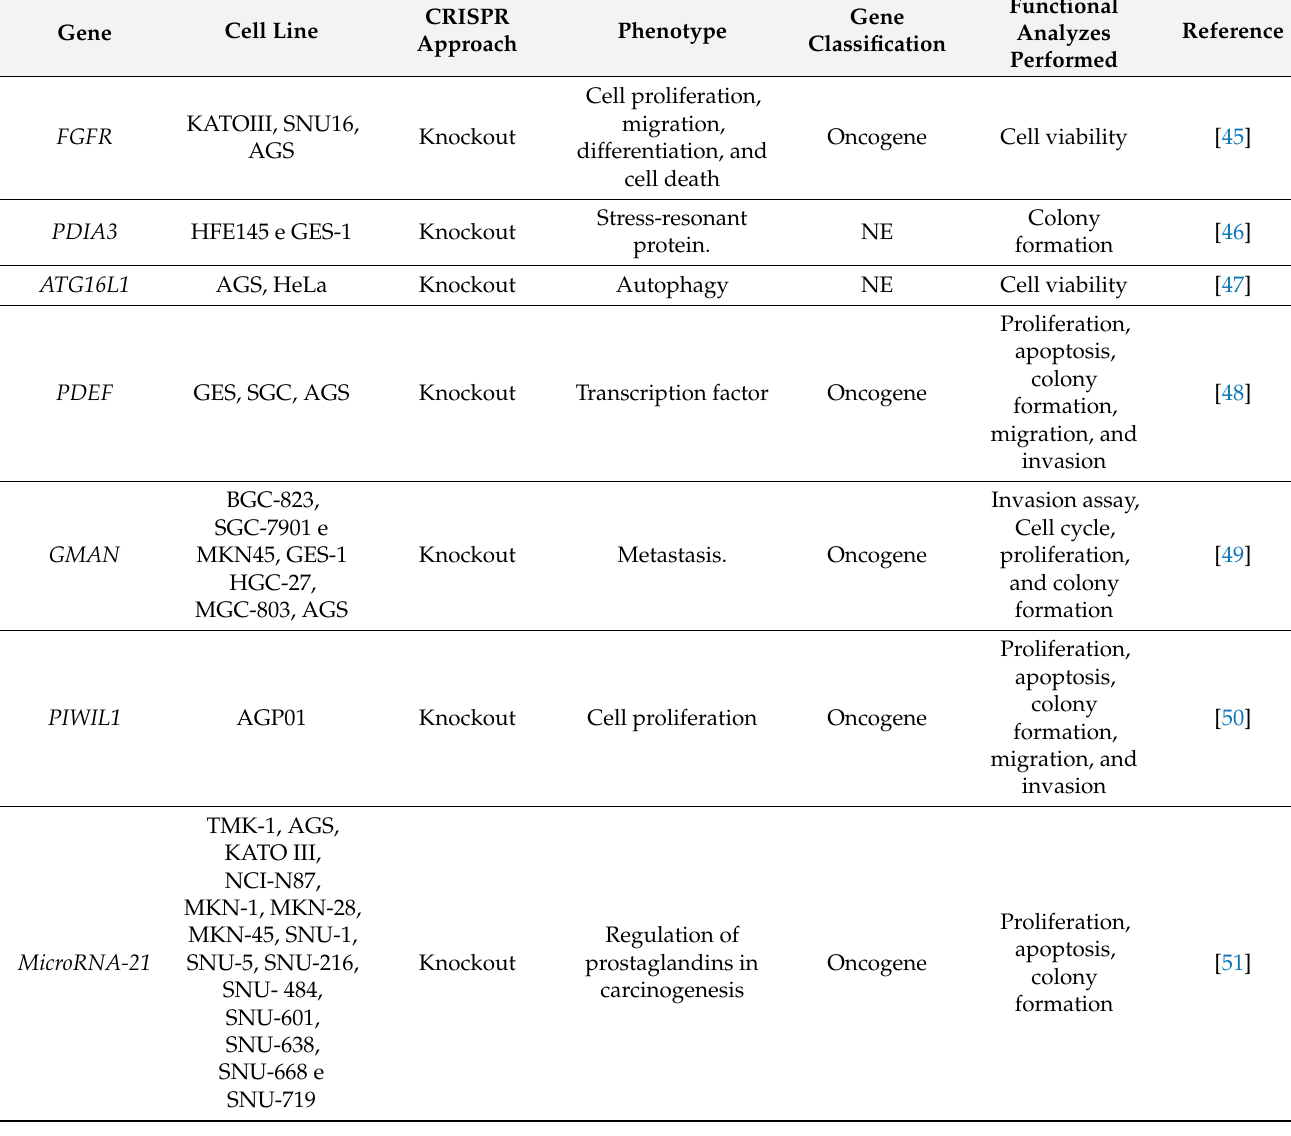
Table 1. Studies performed in gastric cells using the CRISPR/Cas9